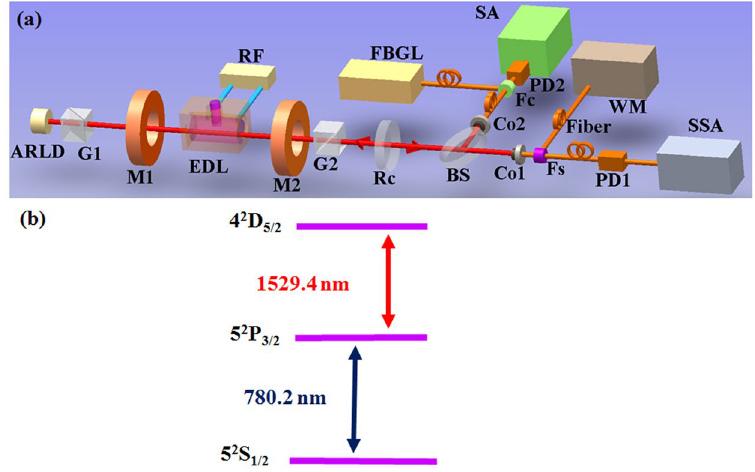
Figure 1. Schematic of the LESFADOF-based Faraday laser lasing on Rb 1529 nm transition with the testing system and relevant energy level diagram. ( a ) Experimental setup of the LESFADOF-based Faraday laser lasing on Rb 1529 nm transition and the measurement system. ARLD, antireflection-coated laser diode; RF, radio- frequency module; M1 and M2: a pair of permanent magnets; EDL, electrodeless discharge lamp; G1 and G2, a pair of Glan–Taylor prisms; Rc, cavity mirror with reflectivity of 80% and the transmission of 20% for 1529 nm; BS, 50% beam splitter for 1529 nm; Co1 and Co2, optical fiber coupler for 1529 nm; Fc, fiber combiner; Fs, fiber splitter; Fiber, single-mode fiber; PD1 and PD2, photodiode; FBGL, fiber Bragg grating laser; SSA, signal source analyzer; WM, wavelength meter; SA, signal analyzer. ( b ) Relevant energy level